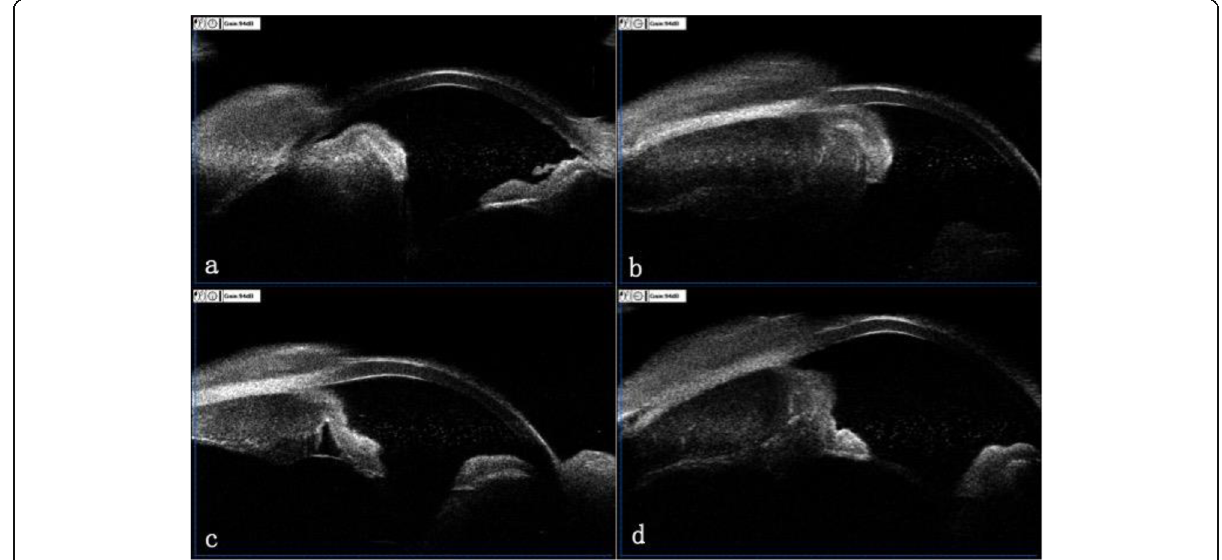
Fig. 5 UBM of right eye before diagnosis vitrectomy of 12 o ’ clock(a), 3 o ’ clock(b), 6 o ’ clock(c) and 9 o ’ clock(d)